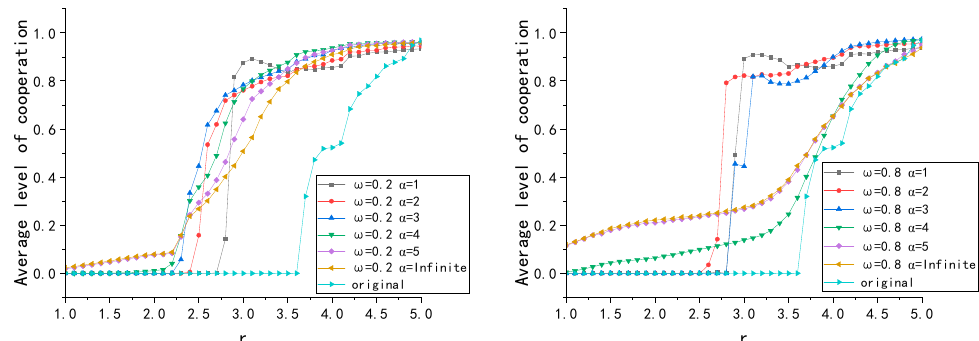
Figure 4. Variation of the average cooperation level with the 𝑟 for six different values of 𝛼 , where 𝜔 is fixed to 0.2 ( left ) and to 0.8 ( right ), respectively. In addition, the “original” curve represents the case of the Fermi update rule.